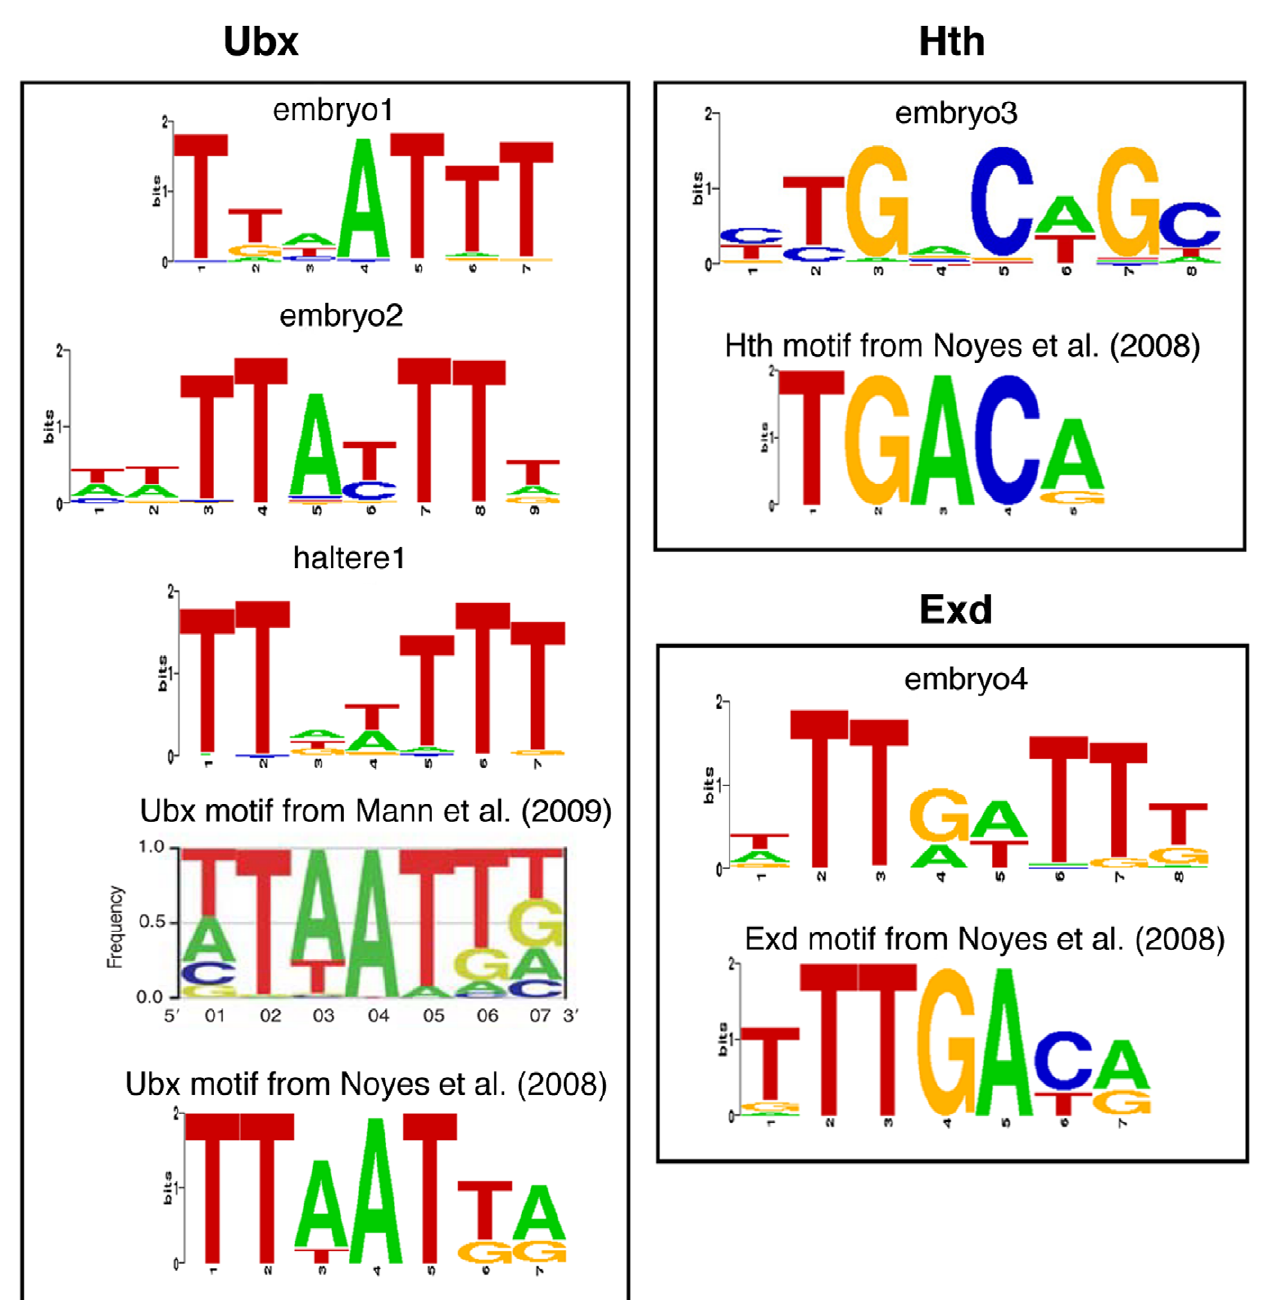
Figure 5. Sequence motifs identified. Enriched motifs derived from the Ubx and Hth ChIP-array data are compared to previously identified motifs from Mann et al. [5] and Noyes et al.